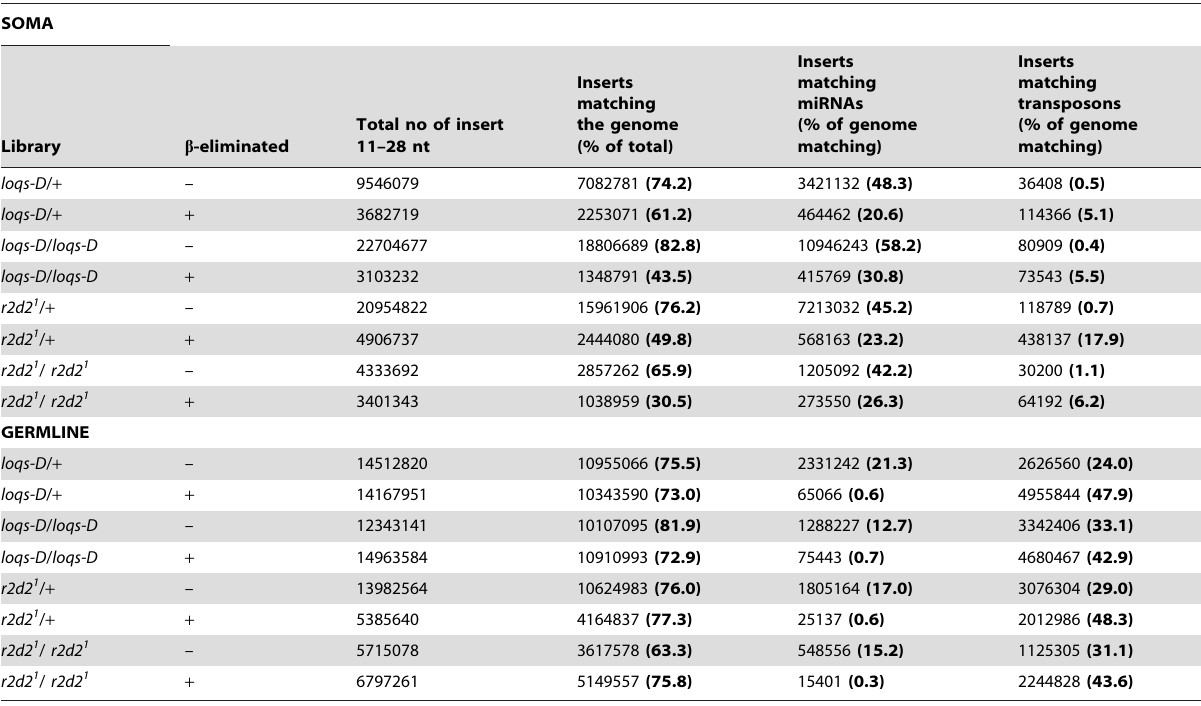
Table 1. Analysis of deep sequencing libraries generated in this study.